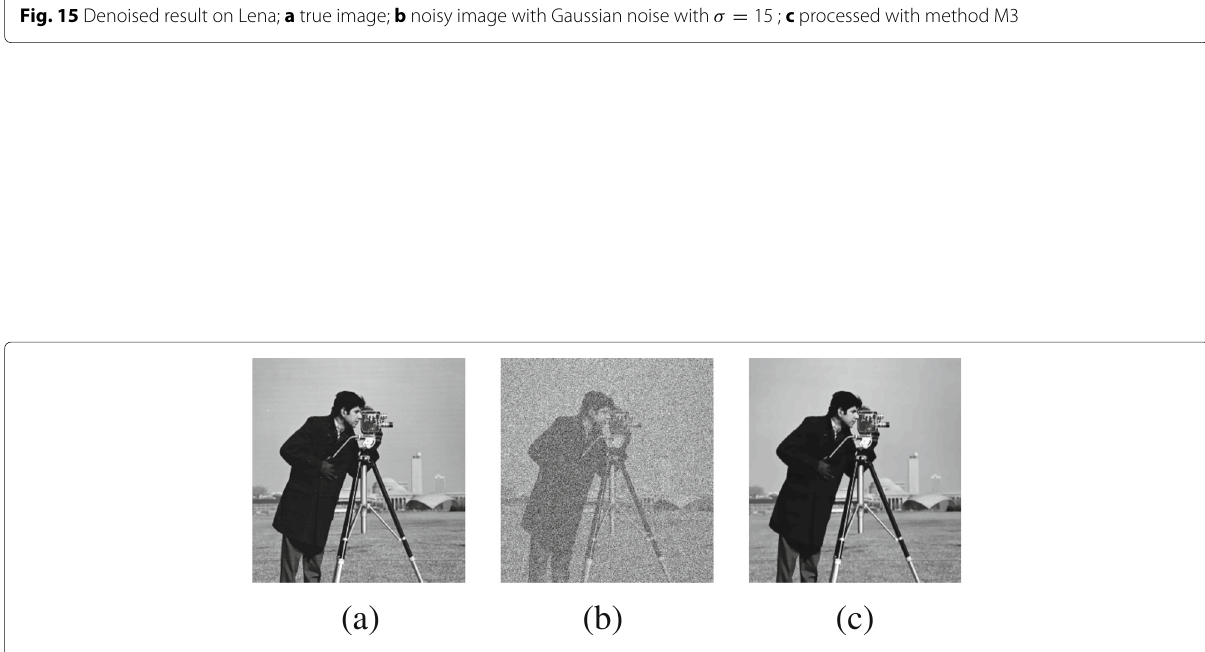
Fig. 16 Reconstructed result on cameraman; a true image; b noisy image with Gaussian noise with σ = 20 ; c denoised with method M3